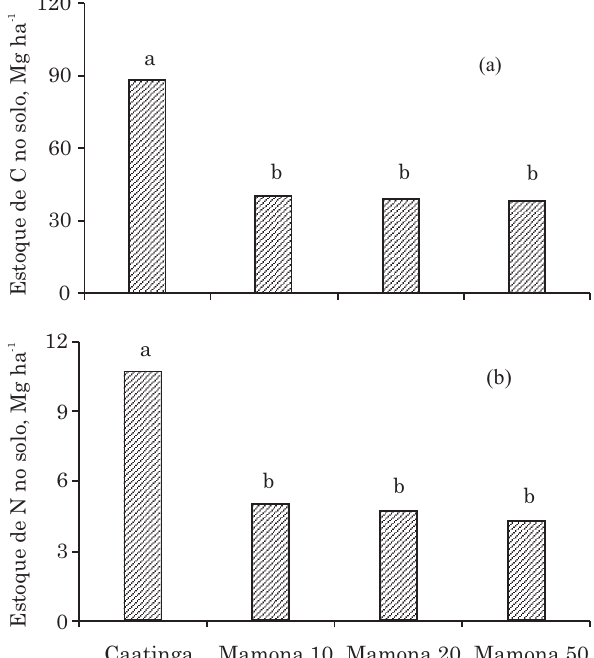
Figura 1. Estoques de carbono (A) e nitrogênio (B) do solo (Mg ha -1 ) para a camada de 0-30 cm nas situações sob vegetação nativa de Caatinga e diferentes tempos de cultivo da mamona (10, 20 e 50 anos) na Fazenda Floresta, no município de Irecê (BA). Letras não diferem estatisticamente pelo teste de SNK (p < 0,05).